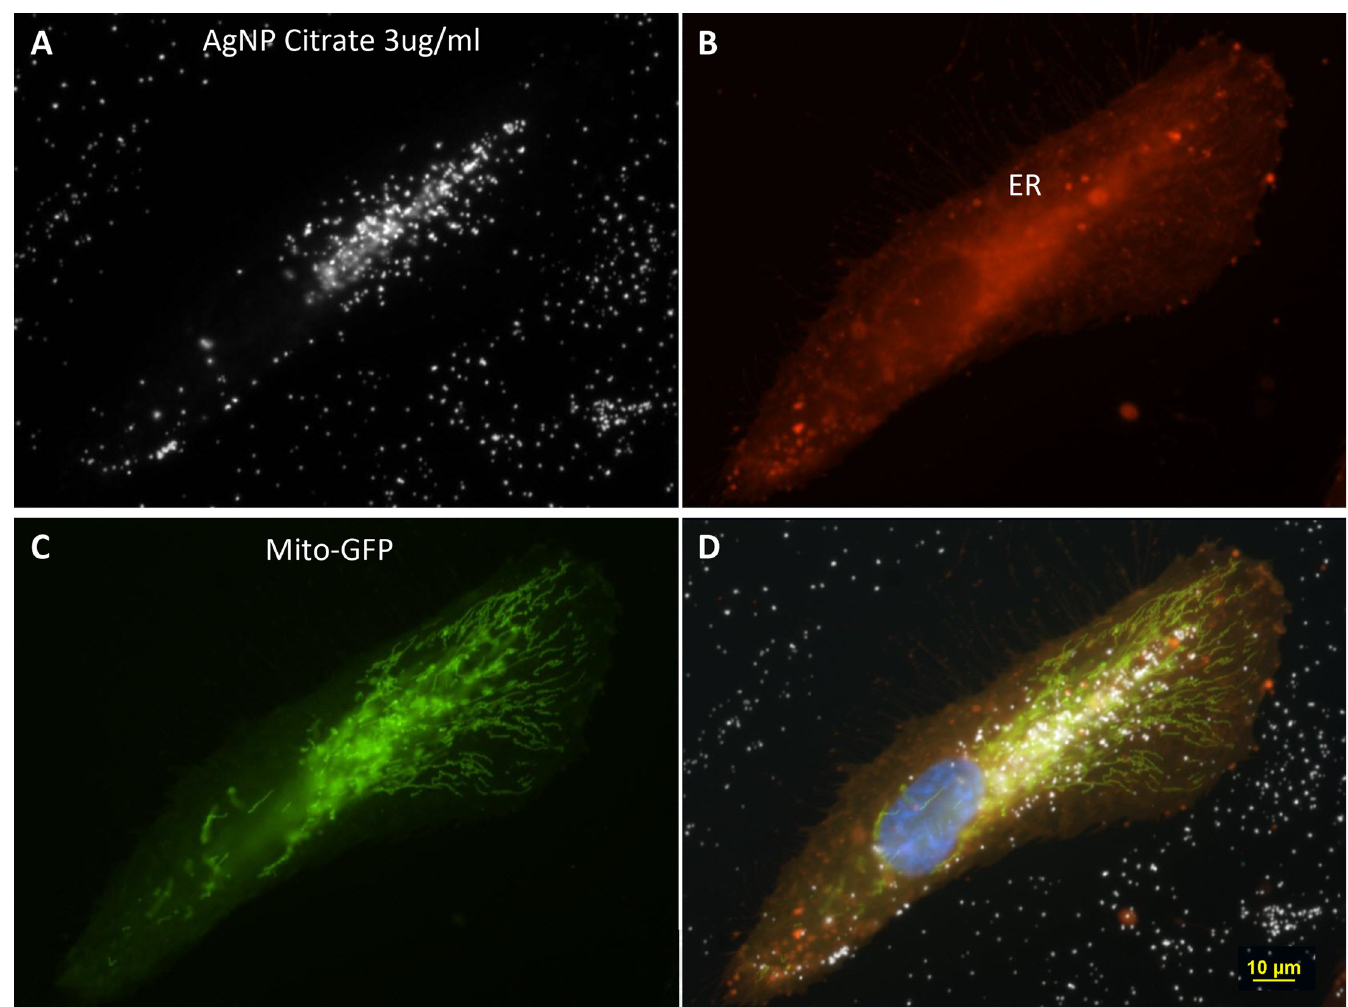
Fig 6. Four different fields of 3ug/ml AgNP citrate obtained with darkfield optics using a 60-x plan Fluor objective with an iris diaphragm (NA 0.55–0.90). Panel A. Intracellular nanoparticles are brighter than the extracellular particles. Panel B. The cytoplasm was stained with CellMask Orange plasma membrane stain (red). Panel C. Cells transfected with Mito-GFP (green). Panel D. A composite image of fields A, B, and C were combined with an image of DAPI stained nuclei (blue). Magnification 600x.